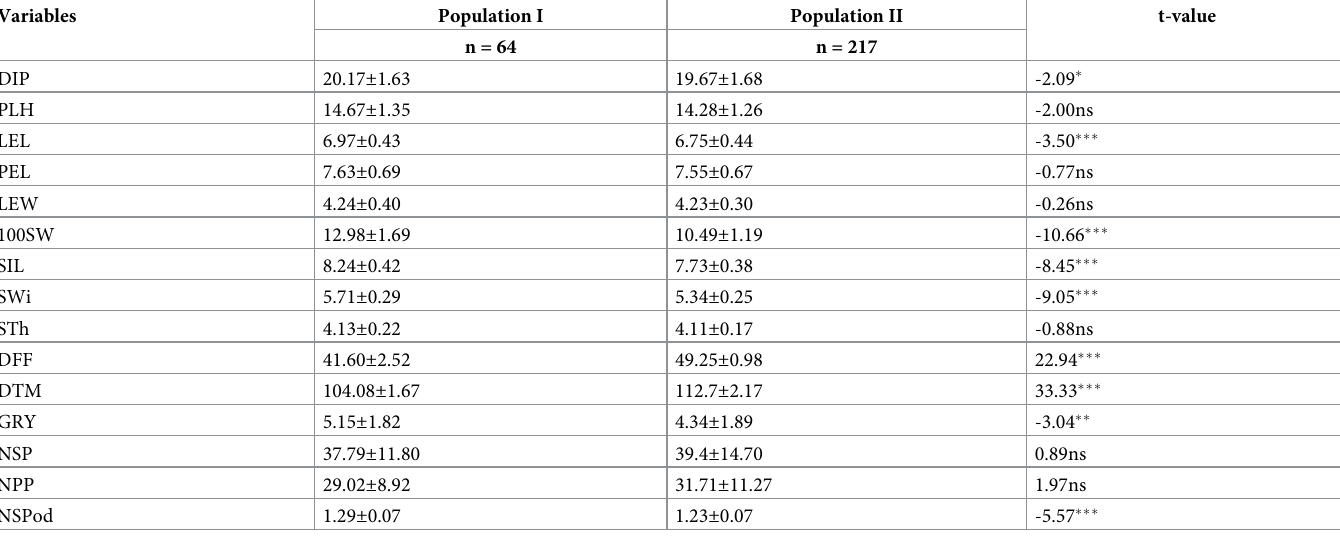
Table 9. Phenotypic means and standard deviation of subpopulations of Kersting’s groundnut accessions and results of Student test of differences between subpopulations.